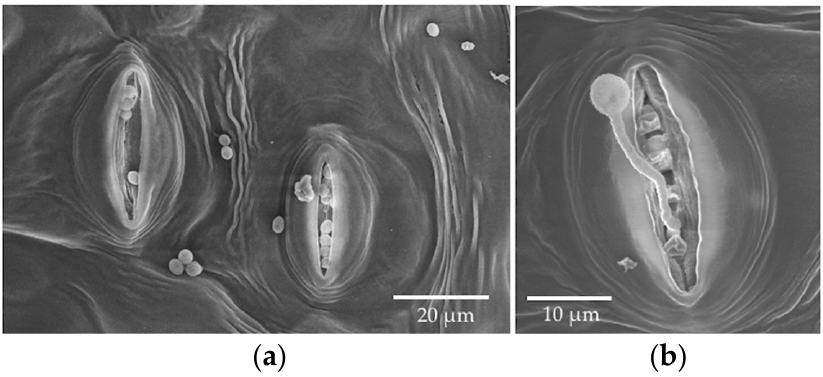
Figure 7. SEM photos from the in vitro inoculation of leaf discs of P. trichocarpa with an endophytic strain of Trichoderma sp. NM2012 at 72 HAI. ( a ) Non-germinated conidia; ( b ) A germinated conidium with hyphal penetration into the stomatal opening.